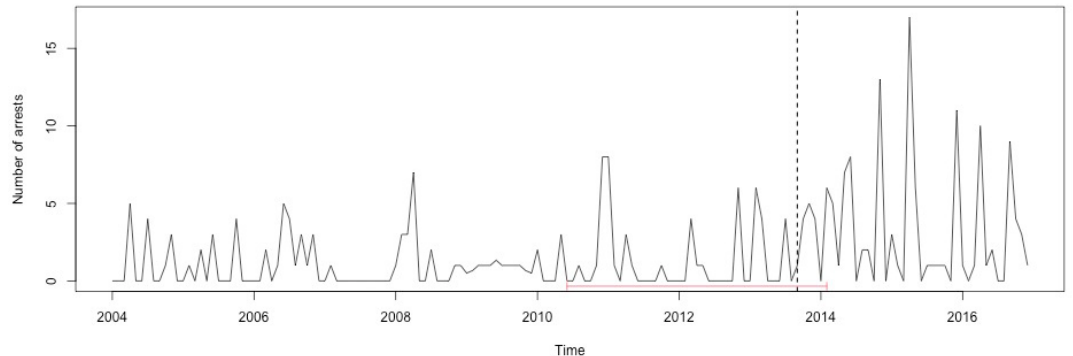
Figure A38. Methamphetamine-related foreign nationals organized crime arrests 2004–2016 in the Czech Republic and structural breaks.